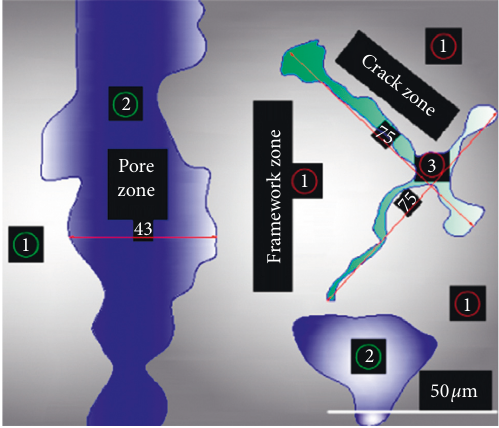
Figure 14: Microstructure of weakly cement mudstones.